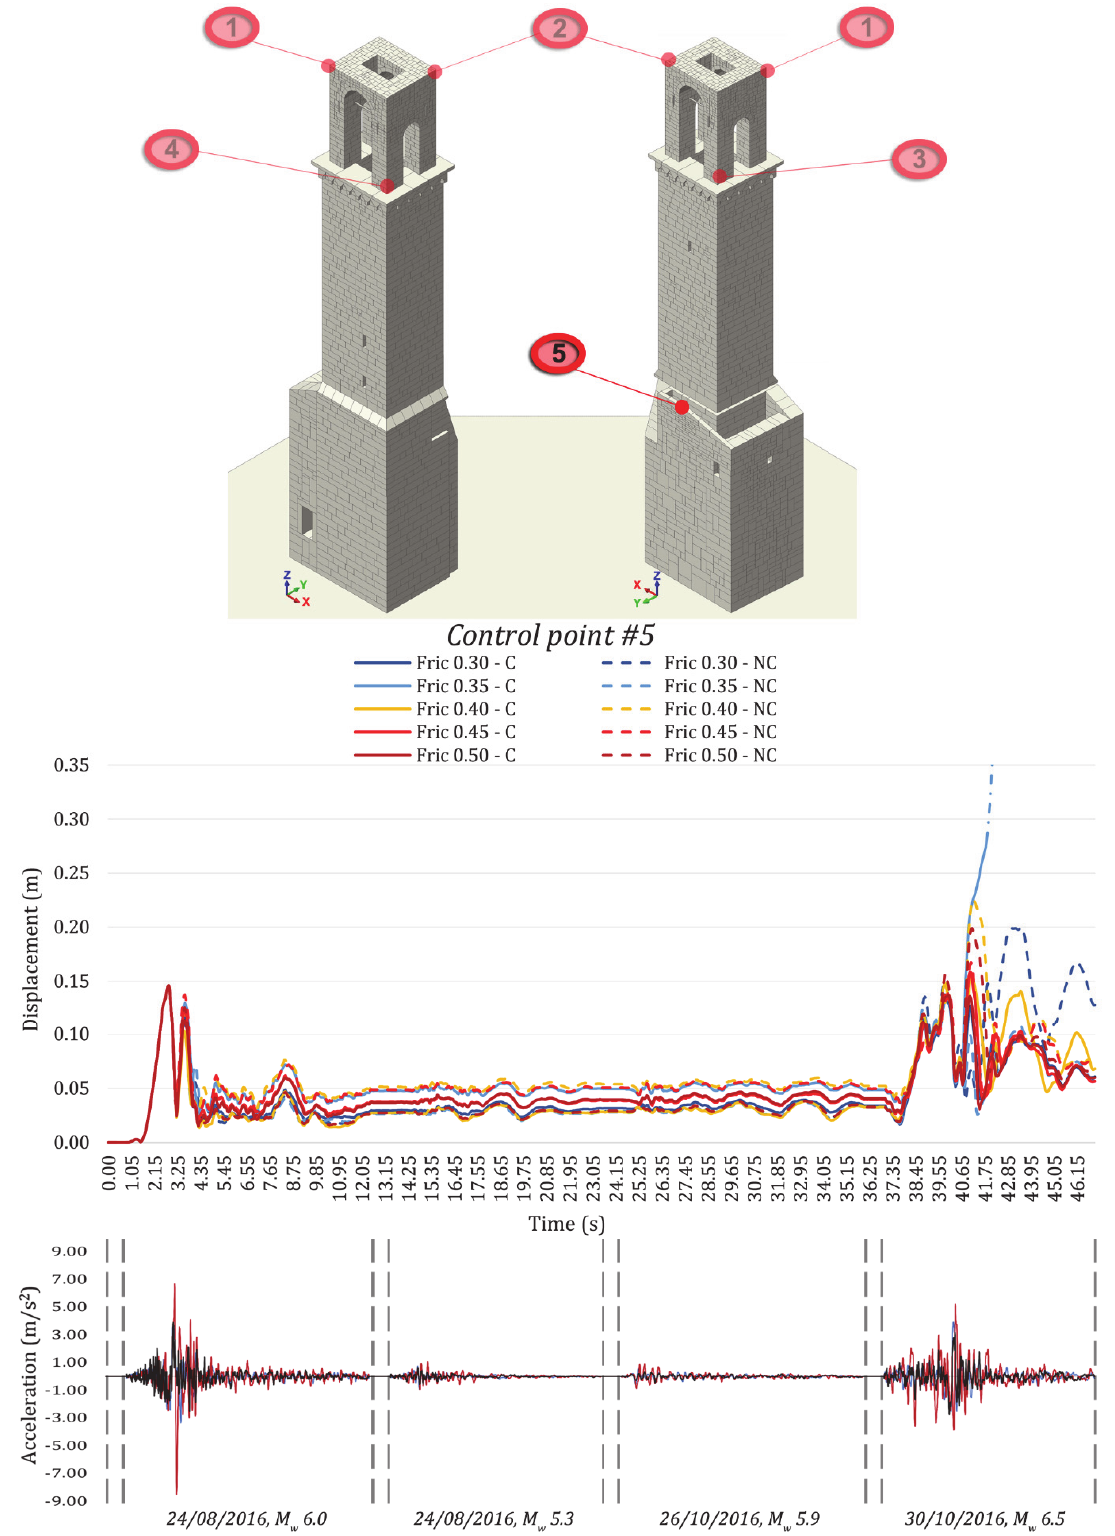
Figure 20: Displacements time histories of the control point #5 of the civic clock tower of Amatrice (Rieti, Italy) under the four main shocks in the three components x,y,z recorded in the village during the Central Italy seismic sequence of 2016 for both configurations, with (namely C) and without (NC) the steel chains, at varying of the friction on the bell